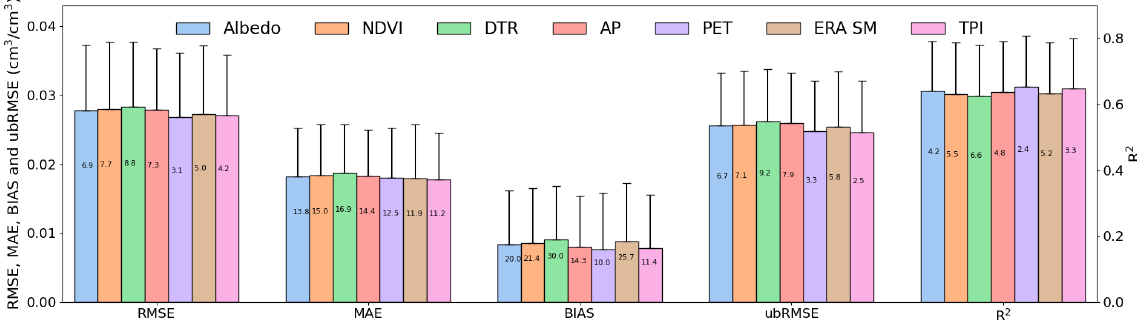
Figure 11. Accuracy of the models removing one variable, i.e., using the other six variables in model regression. Error bars denote 1 σ errors. The text denotes the relative percentage of the decreased accuracy of the model with six variables (i.e., excluding one) in comparison with that of a model with seven